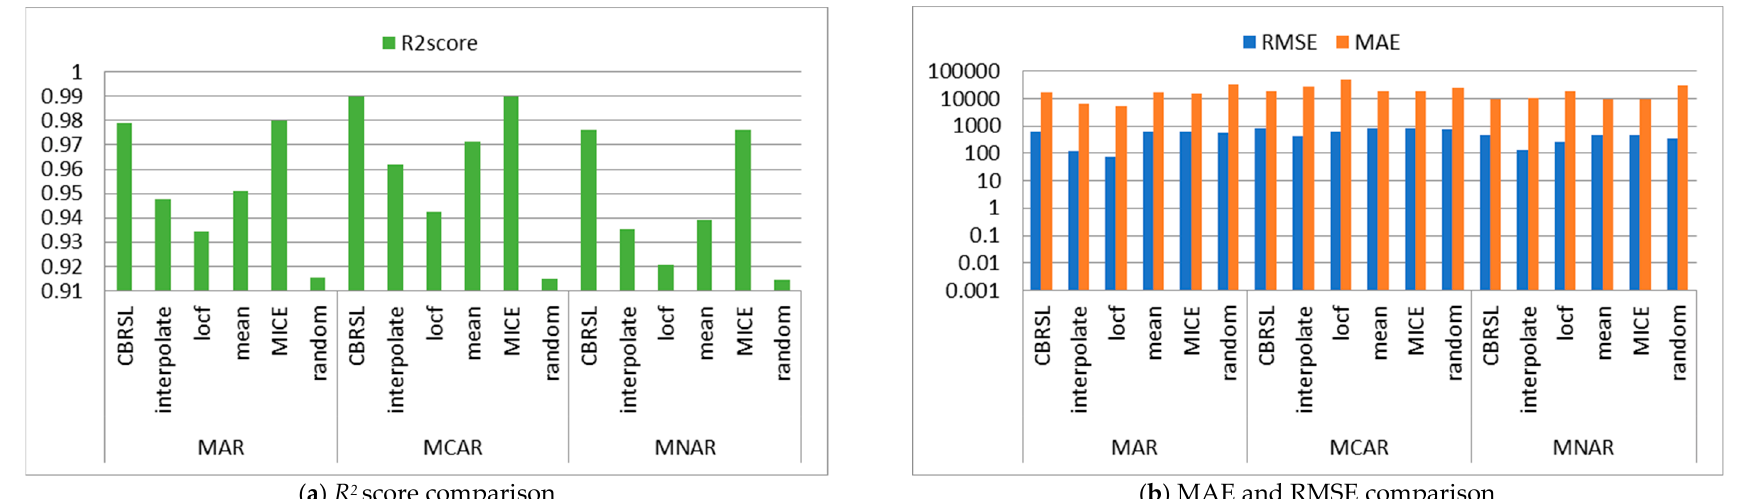
Figure 4. Comparison between the proposed algorithm, interpolate, locf, mean, MICE and random methods (Breast Cancer Wisconsin Dataset).